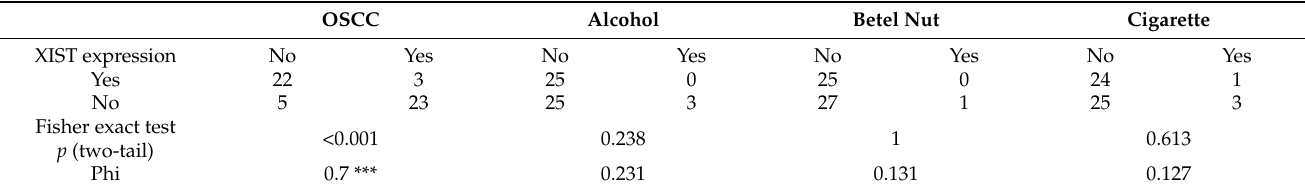
Table 4. The XIST expression and the correlation of OSCC among females ( n =